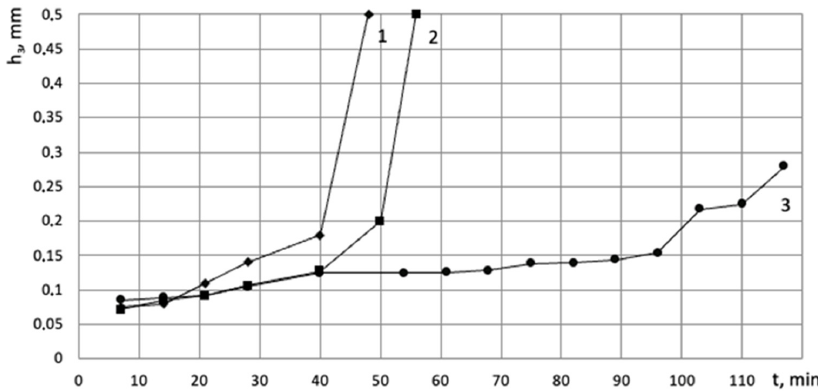
Figure 10. Graph of the dependency of flank wear vs. machining pattern: 1—cutter No. 1; 2—cutter No. 2; 3—cutter No. 3.